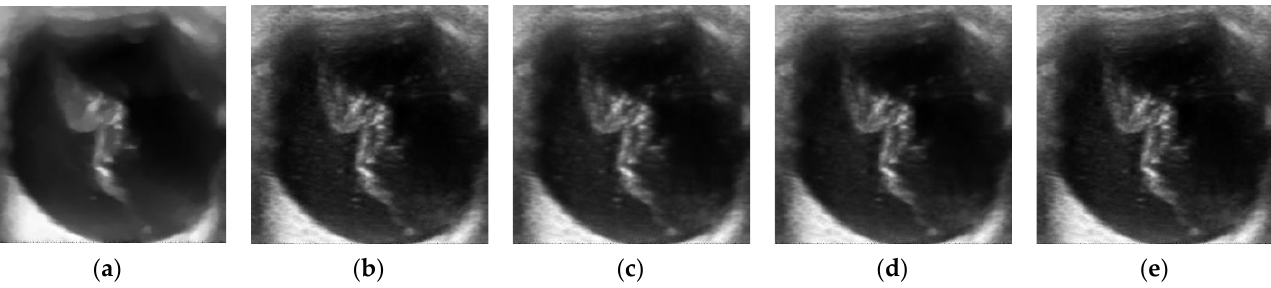
Figure 5. Results of vitreous hemorrhage image processing by different orders of α denoising model. ( a ) α = 1. ( b ) α = 0.4. ( c ) α = 0.8. ( d ) α = 1.2. ( e ) α = 1.6.